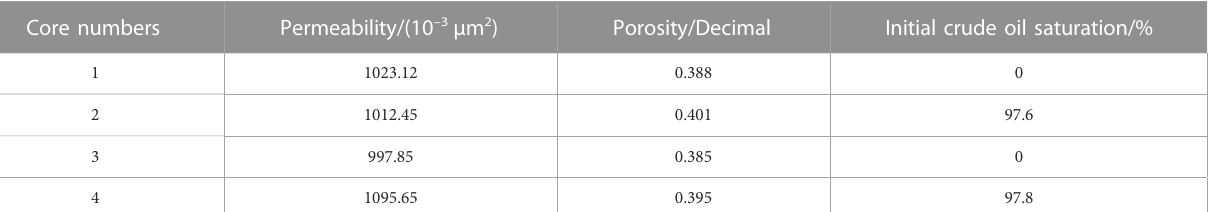
TABLE 1 Sand fi lling core parameters table.